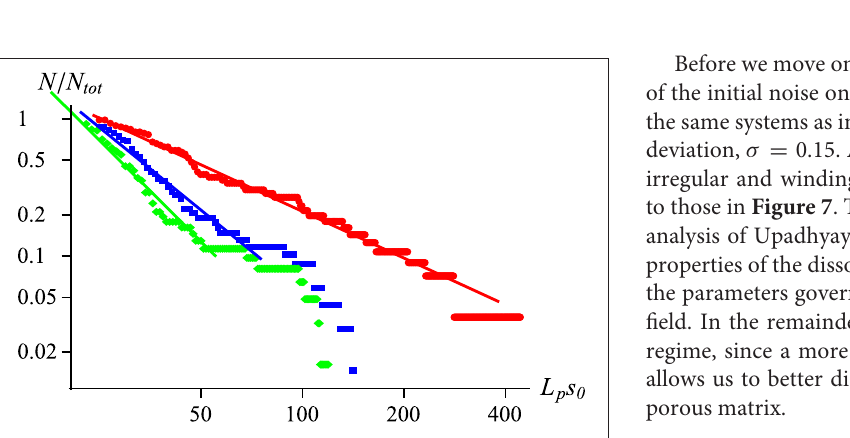
FIGURE 8 | The cumulative distribution N ( L ) of solution pipe lengths for the patterns presented in Figure 7 with C = 1 (red points), C = 2 (blue), and C = 4 (green). The solid lines have slopes of 1.02 (red), 1.95 (blue), and 2.45